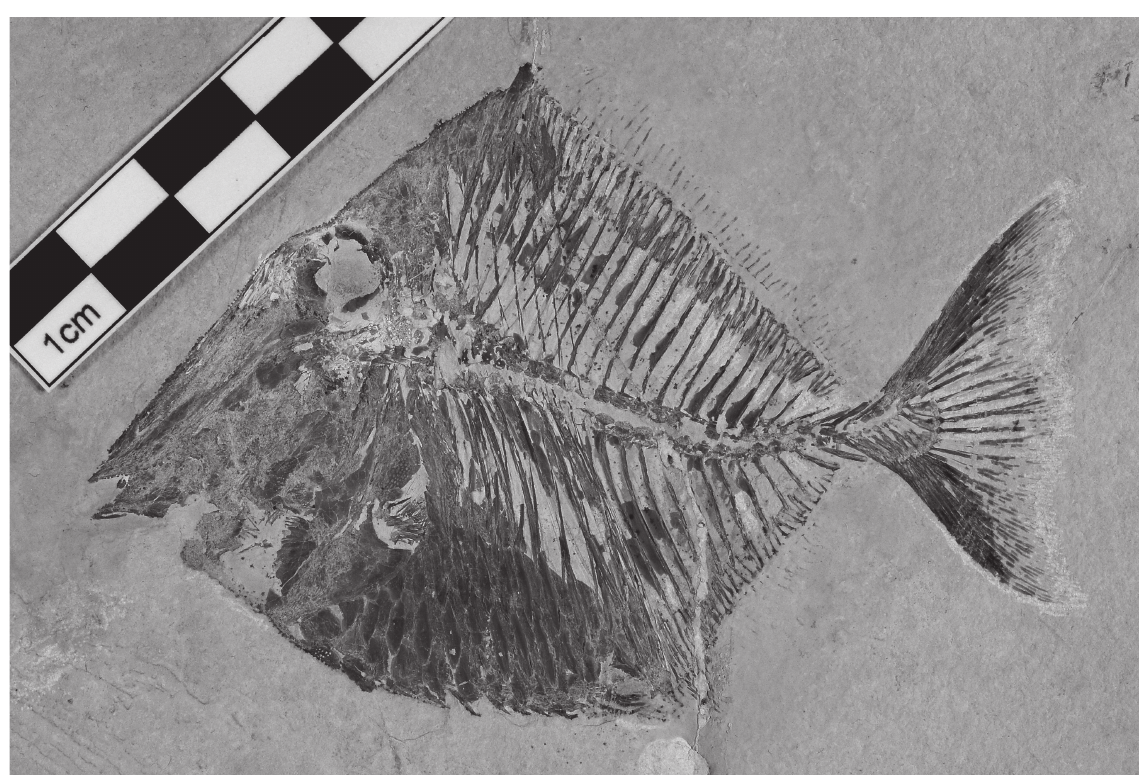
Fig. 1. Acrorhinichthys poyatoi gen. et sp. nov. Holotype CLC S-630a.